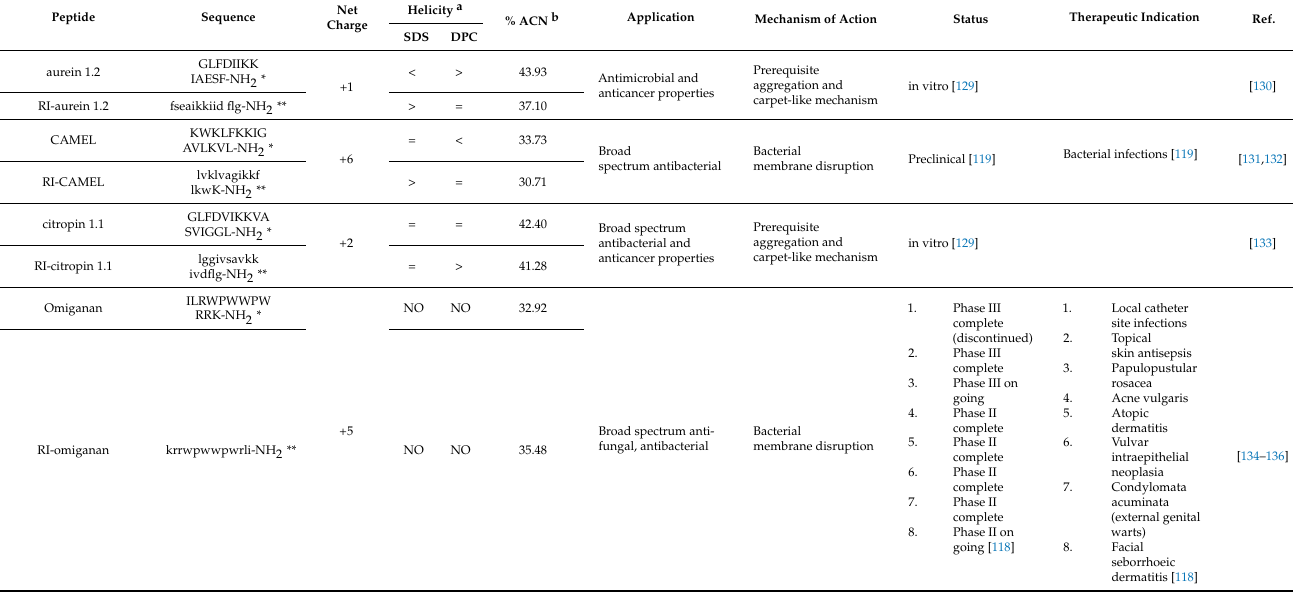
Table 2. Peptide-based antimicrobial compounds in clinical trials and their retro-inverso analogues, based on